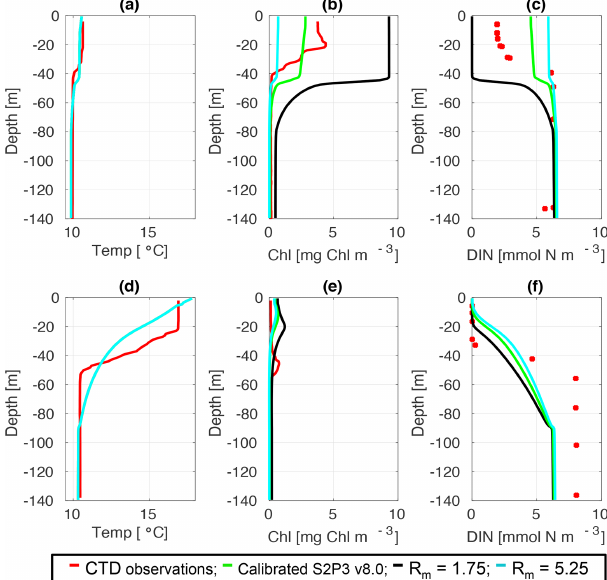
Figure C2. CTD observations from the SSB programme (red line) including data for springtime (20 April 2015) (a) tempera- ture, (b) chlorophyll a , and (c) DIN (red dots); for summertime (24 July 2015) for (d) temperature, (e) chlorophyll a , and (f) DIN (red dots) along the calibrated S2P3 v8.0 model (green line), exper- iments R max = 1 . 75 (black line) and R max = 5 . 25 (cyan line).